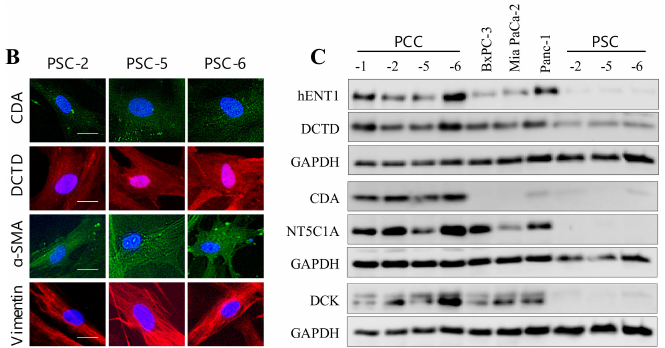
Figure 5. Expression analysis of key regulators of gemcitabine uptake and metabolism. Human PDAC-derived PCCs, the PDAC cell lines ( A ) and PSCs ( B ) seeded in 96-well plates were immunostained ( A , B ) or lysed and proteins, subjected to immunoblotting using antibodies against the indicated targets ( C ). Representative immunofluorescence images of three replicates of PCCs and cell lines ( A ) and PSCs ( B ). Scale bar = 10 µ m. GAPDH was used as a loading control ( C ). PCCs (passage-4) and PSCs (passage-6) were used for western blot and immunofluorescence, respectively. CDA, cytidine deaminase; CK-19, cytokeratin 19; DCK, deoxycytidine kinase; DCTD, deoxycytidylate deaminase;